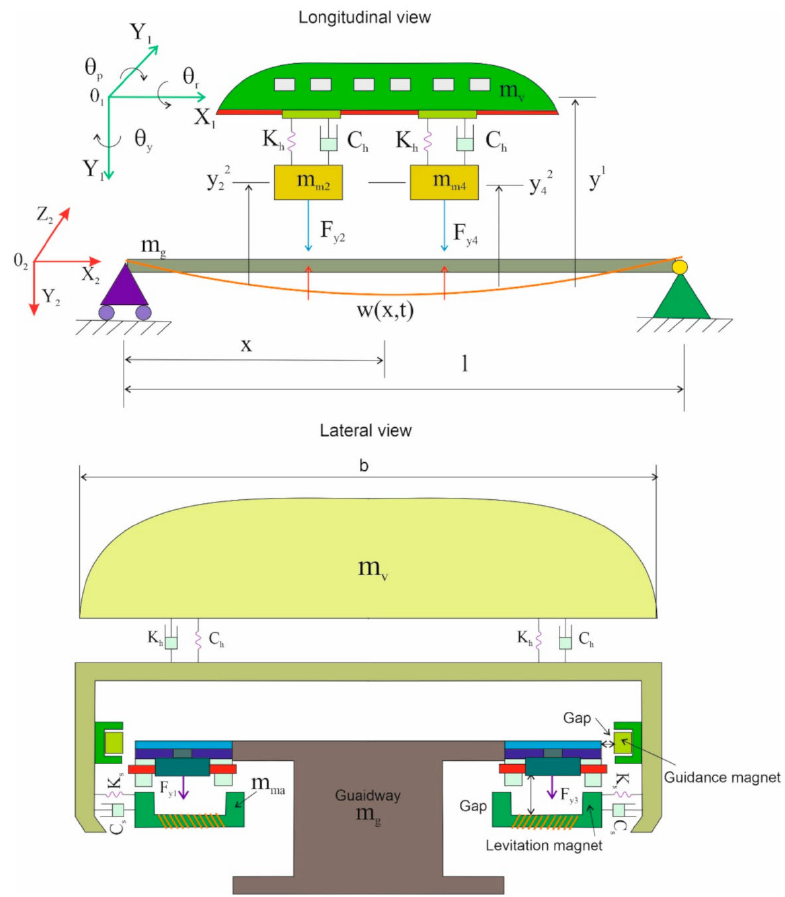
Figure 2. Hyperloop discrete